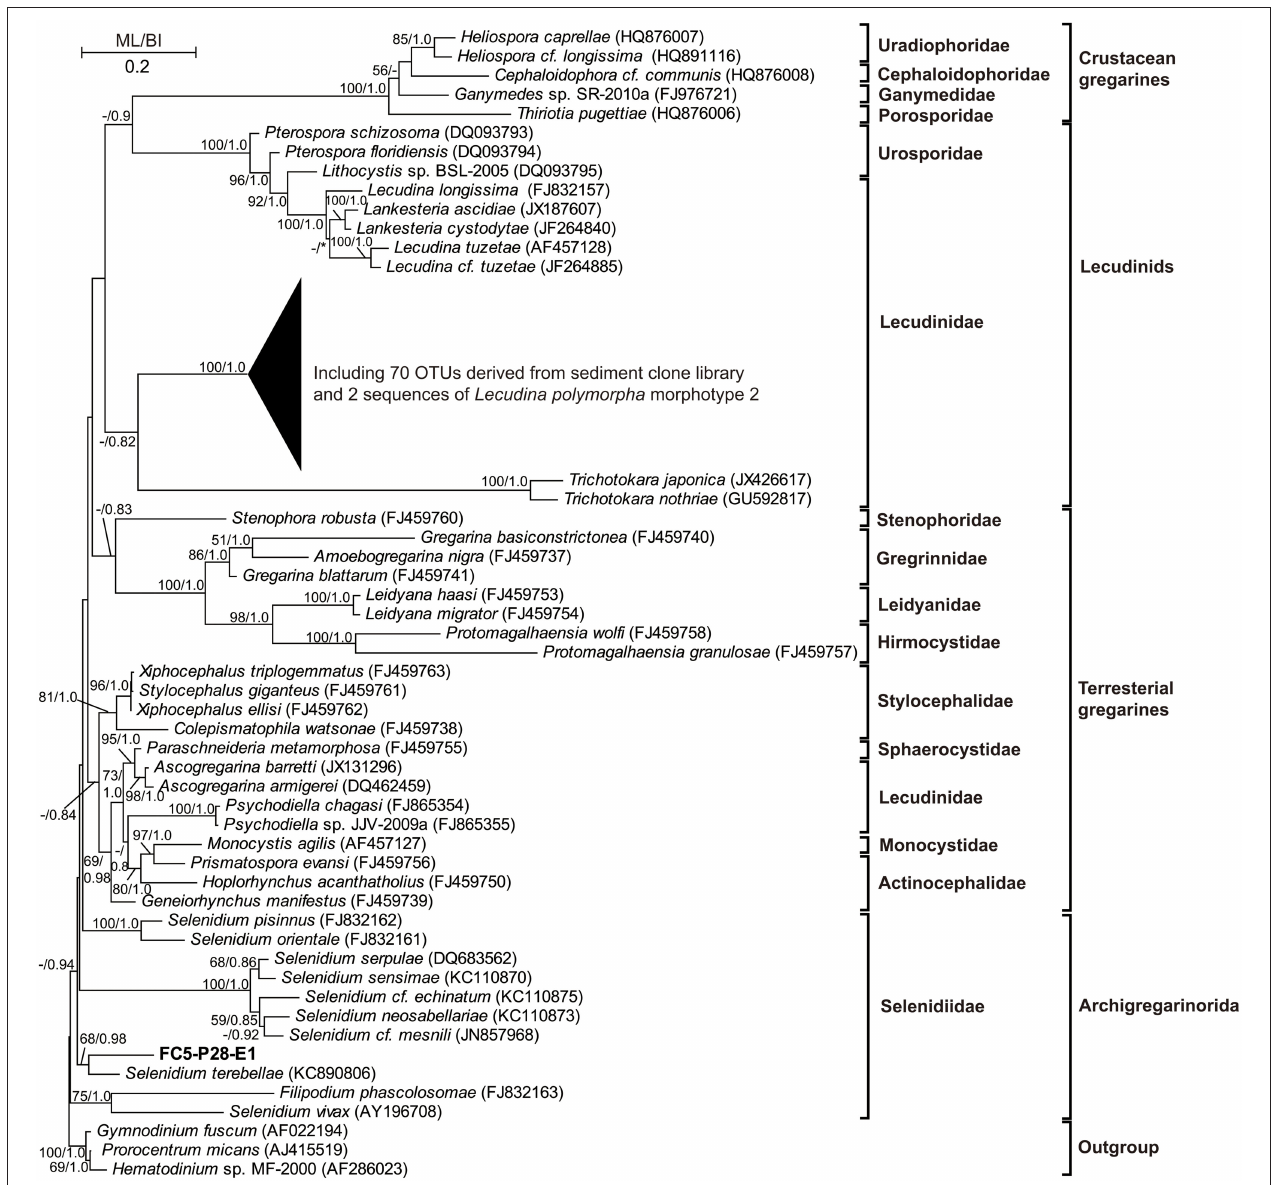
FIGURE 4 | A phylogenetic tree based on 18S rRNA genes and constructed using maximum likelihood (ML) and Bayesian inference (BI) algorithms, showing that most of the gregarine (Apicomplexa) sequences/OTUs obtained from the clone libraries are closely related to that of a described species, Lecudina polymorpha morphotype 2 (family Lecudinidae). A few sequences representing a single OTU are affiliated with the genus Selenidium (family Selenidiidae). Only bootstrap values > 50 and posterior probability > 0.8 are shown at the nodes; the lower values are indicated with dashes. Asterisks refer to alternate topologies.